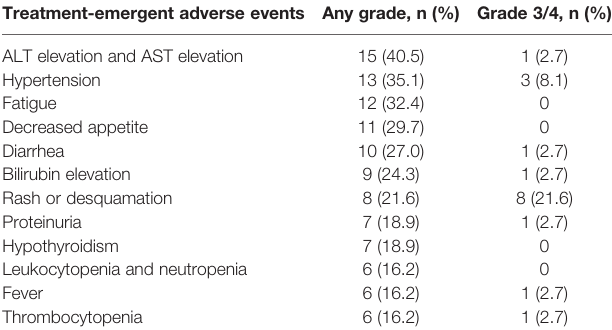
TABLE 3 | Treatment-emergent adverse events. Treatment-emergent adverse events Any grade, n (%) Grade 3/4, n (%) ALT elevation and AST